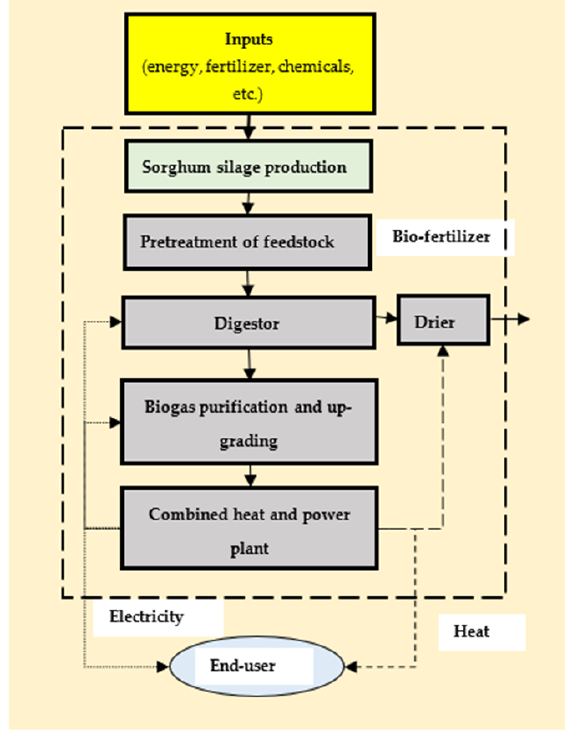
Figure 2. A system boundary of a biogas power plant.